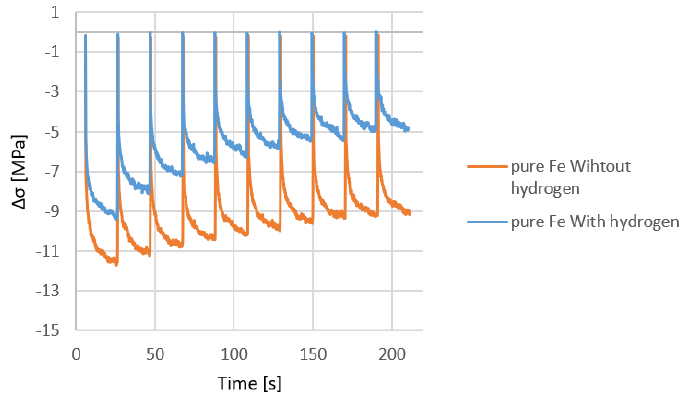
Figure 9. Stress-relaxation test of Fe in the thermally treated state.